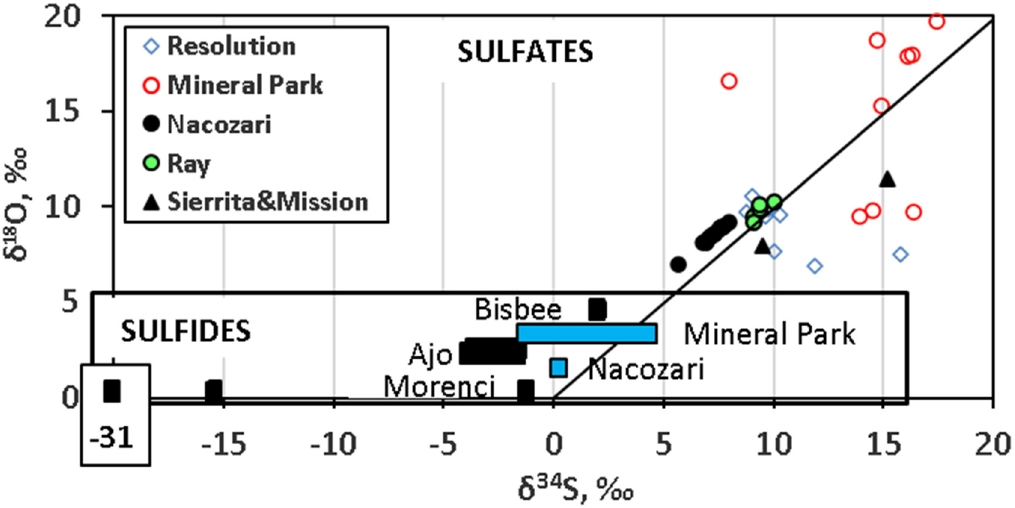
Figure 3. Values and ranges of δ 34 S and δ 18 0 for sulfate and sulfide minerals in porphyry copper deposits of the study area. Values for anhydrite are presented as a plot of δ 18 0 vs. δ 34 S. Ranges for sulfide minerals are shown in the inset. Data sources: Mineral Park [73], Morenci [72], Ajo and Bisbee [76], Nacozari [81], others, this study.